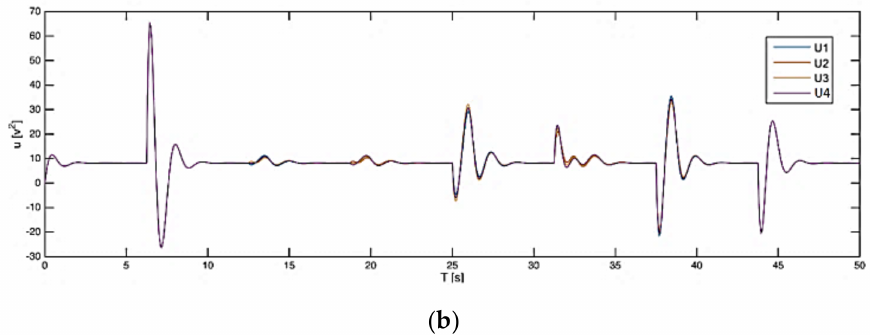
Figure 13. ( a ) Control Input without Disturbances and ( b ) Control Input with Disturbances.